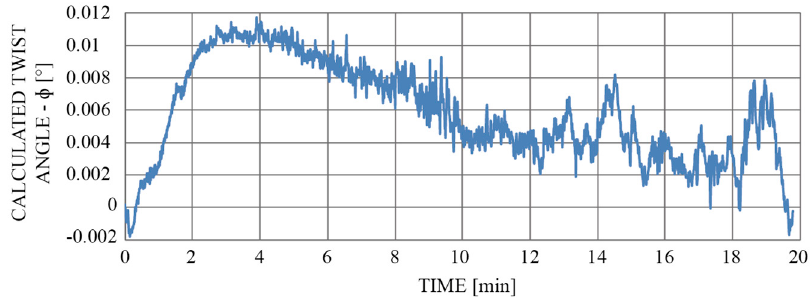
Figure 13. Influence of the change in temperature on the calculated twist/rotation angle measurement when the sensor was heated by about 100 °C.